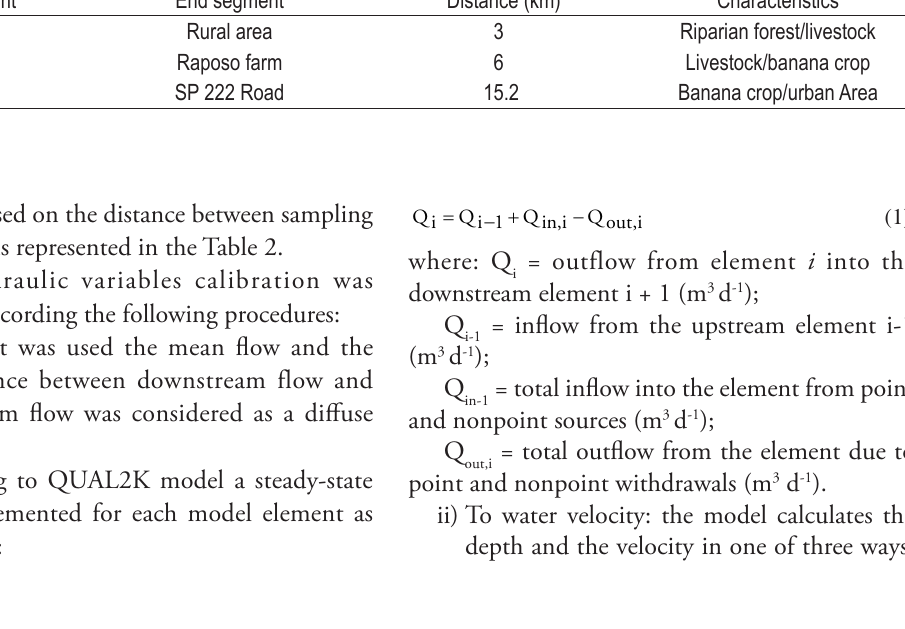
Figure 1. Schematic map showing Ribeira de Iguape Watershed, São Paulo State, Brazil, and Canha River Watershed with sampling stations. Fonte: IBGE Table 1. Representation of the simulated segments. Segment